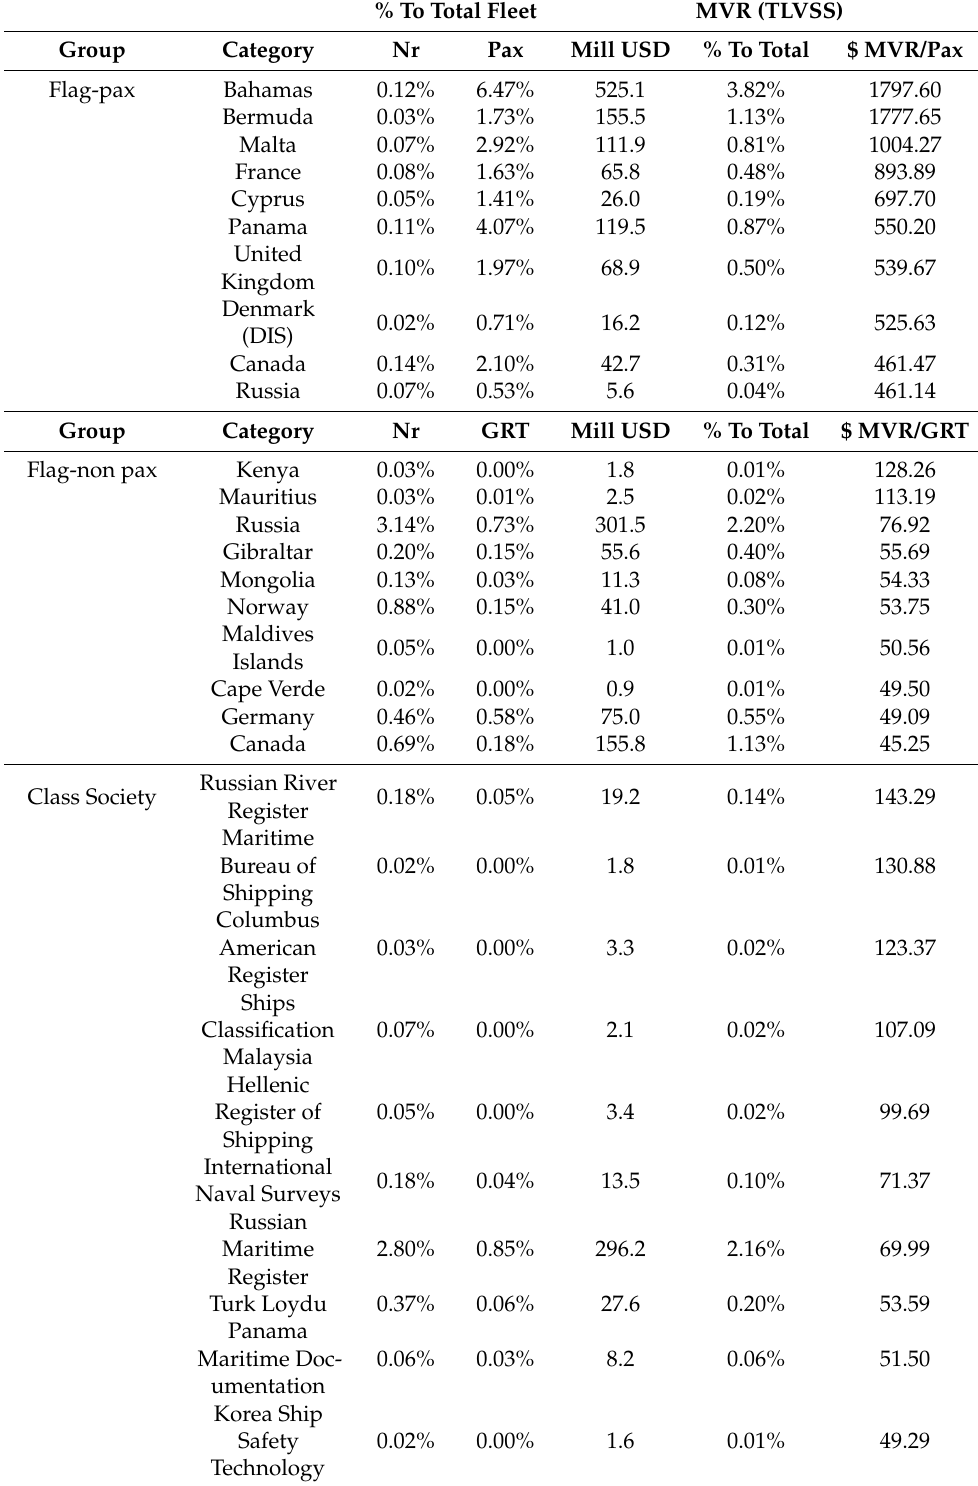
Table A4. MVR by GRT—top 10 by MVR/GRT or Pax (2017 to